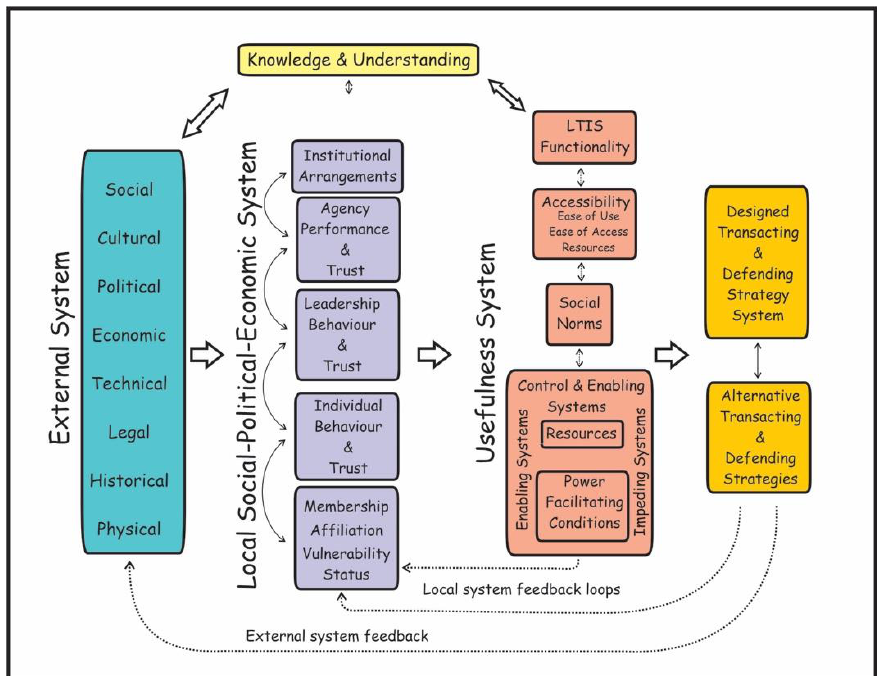
Figure 2. Community Records System Analysis Framework.